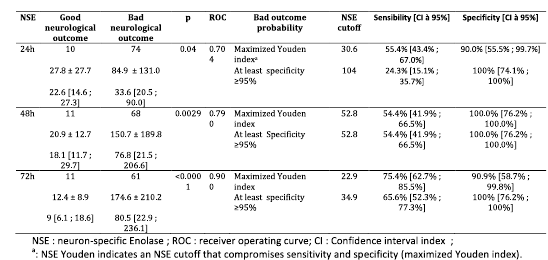
Fig. 1 CAHP score and outcome with detailed mode of death